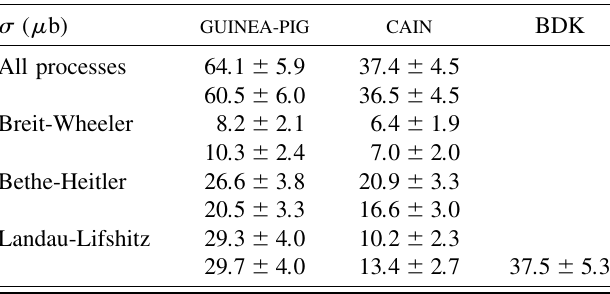
TABLE IV. Cross sections for the pair background reaching the VD predicted by GUINEA-PIG , CAIN , and BDK, with (upper lines) and without (lower lines) the ‘‘beam-size effect.’’ (cid:5) ( (cid:6) b )